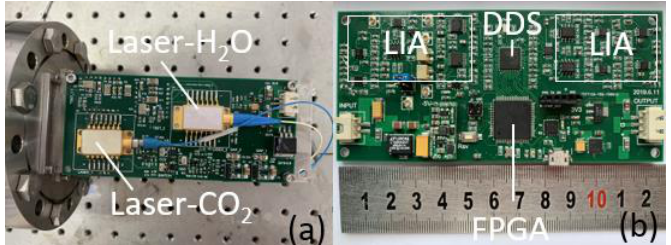
Figure 2. Diagram of the scanned-wavelength WMS- θ 1f based CO 2 and H 2 O detection system, which consists of an open-path multi-pass cell and a reference gas cell for regular CO 2 auto-calibration. The field-programmable gate array-based (FPGA) lock-in detection used a direct digital synthesizer (DDS) to generate scanned-modulation laser driver current, demodulate the 1f signal, calculate the gases concentration and store measurement results to a SD memory card. WMS, wavelength modulation spectroscopy.